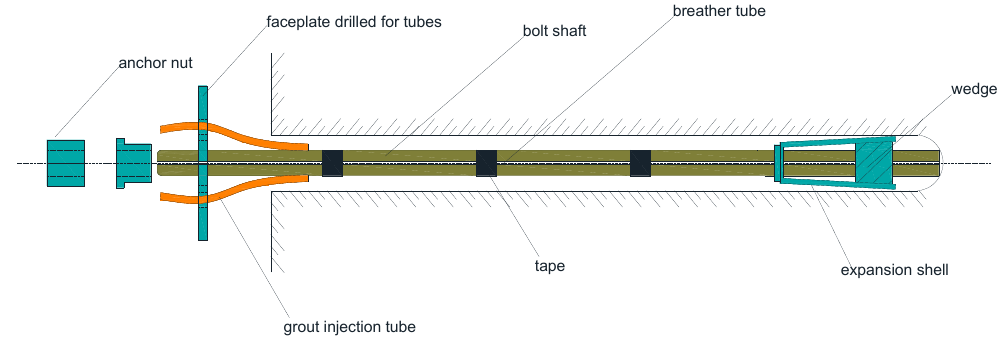
Figure 1. Components of an expansion shell type mechanically anchored rock bolt with provision for grouting.